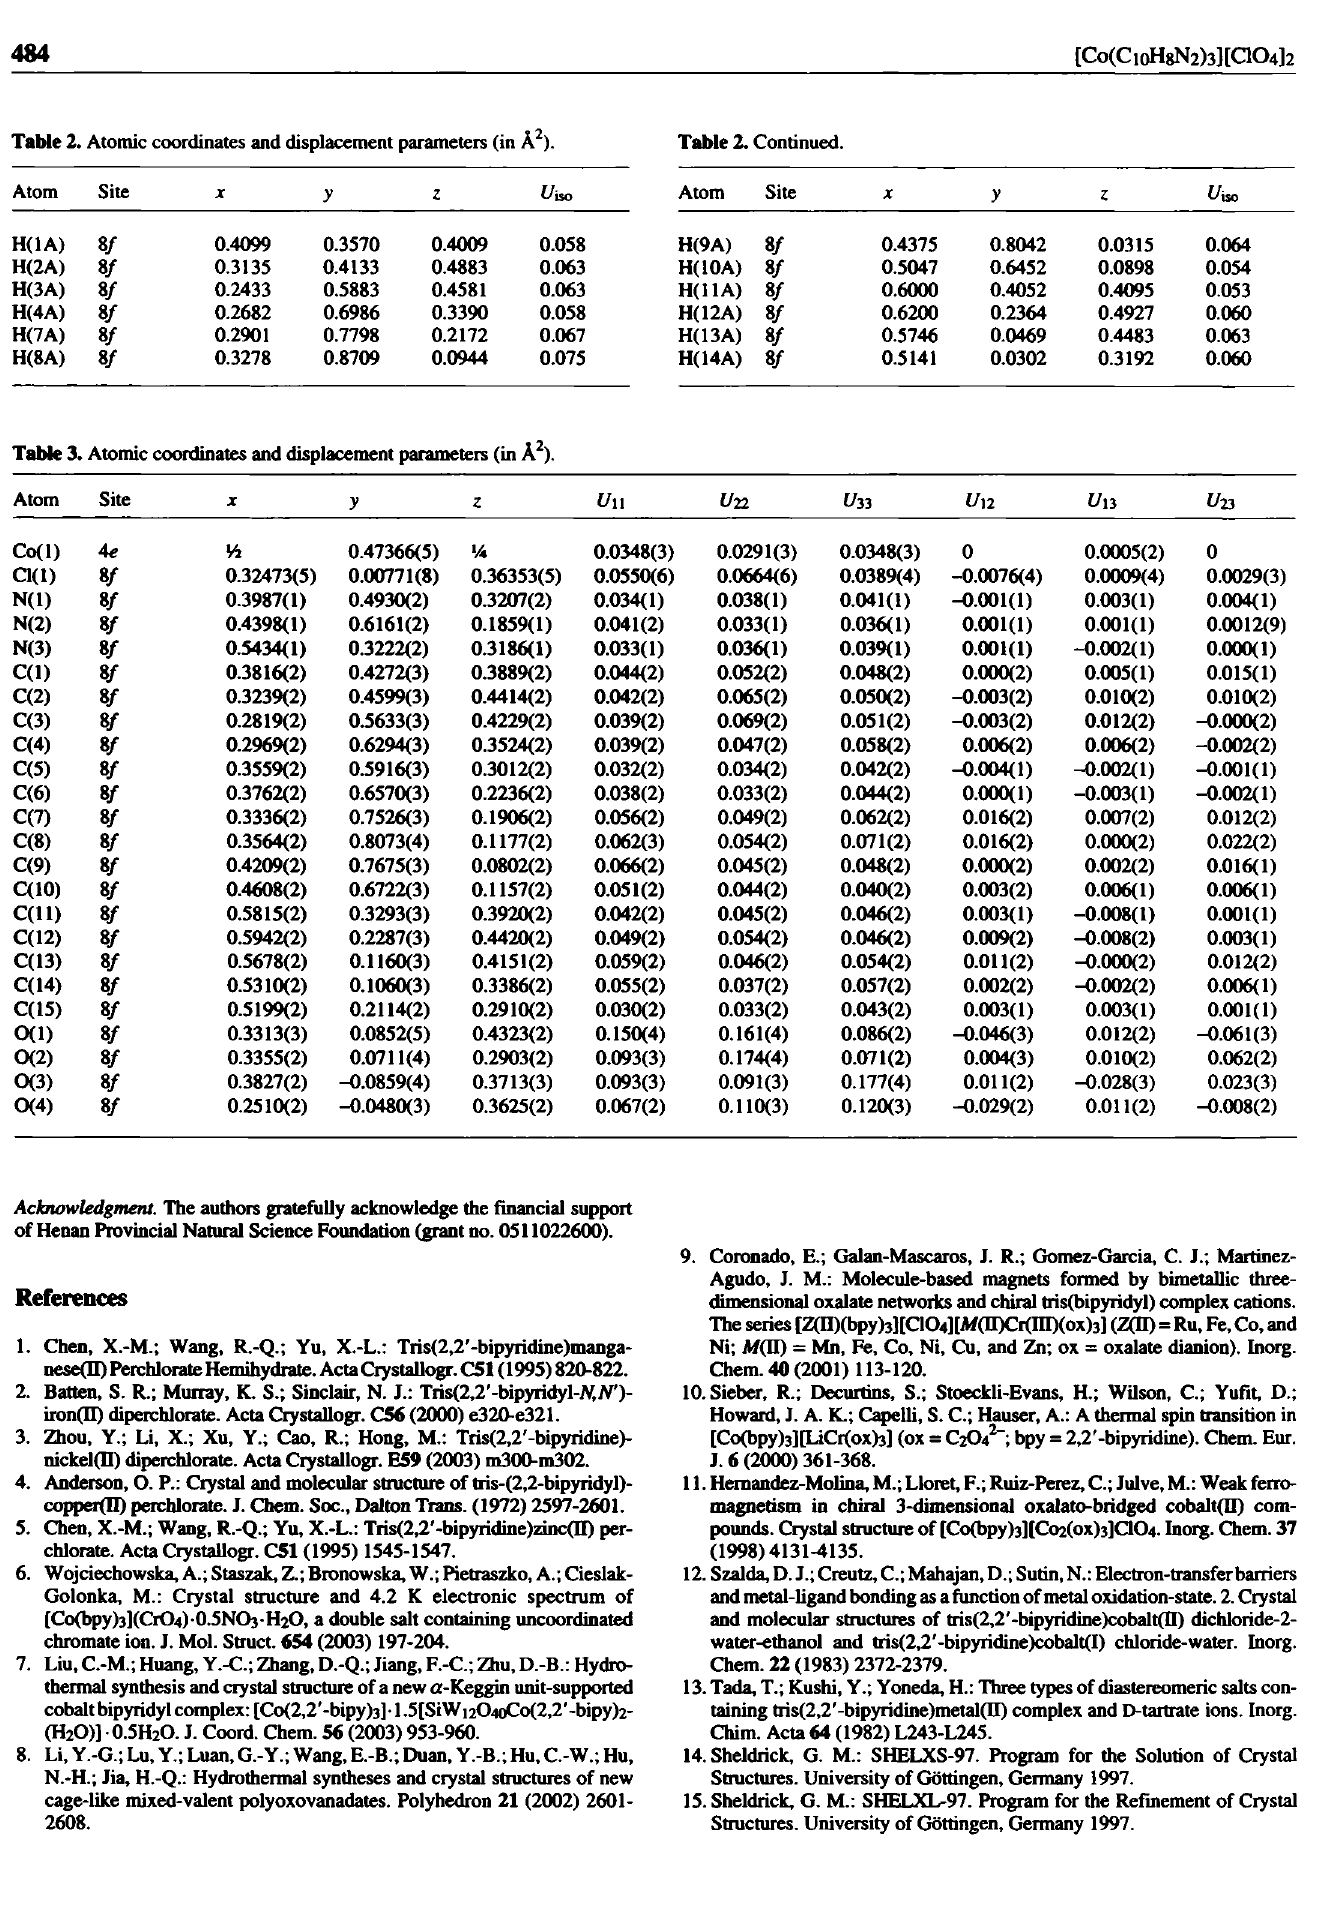
Table 2. Atomic coordinates and displacement parameters (in Ä 2 ).